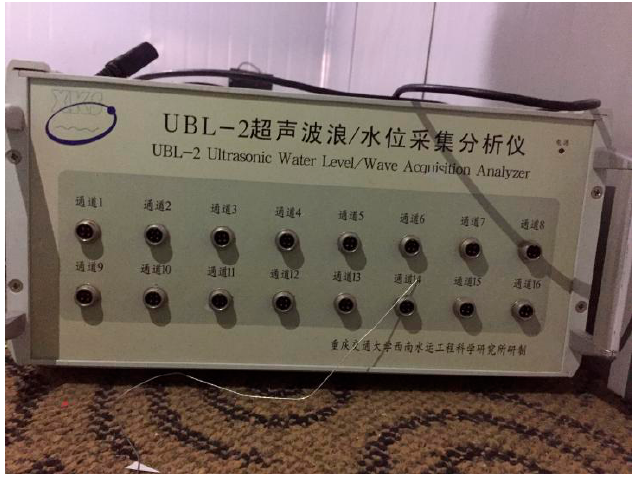
Figure 5. Wave acquisition analyzer.